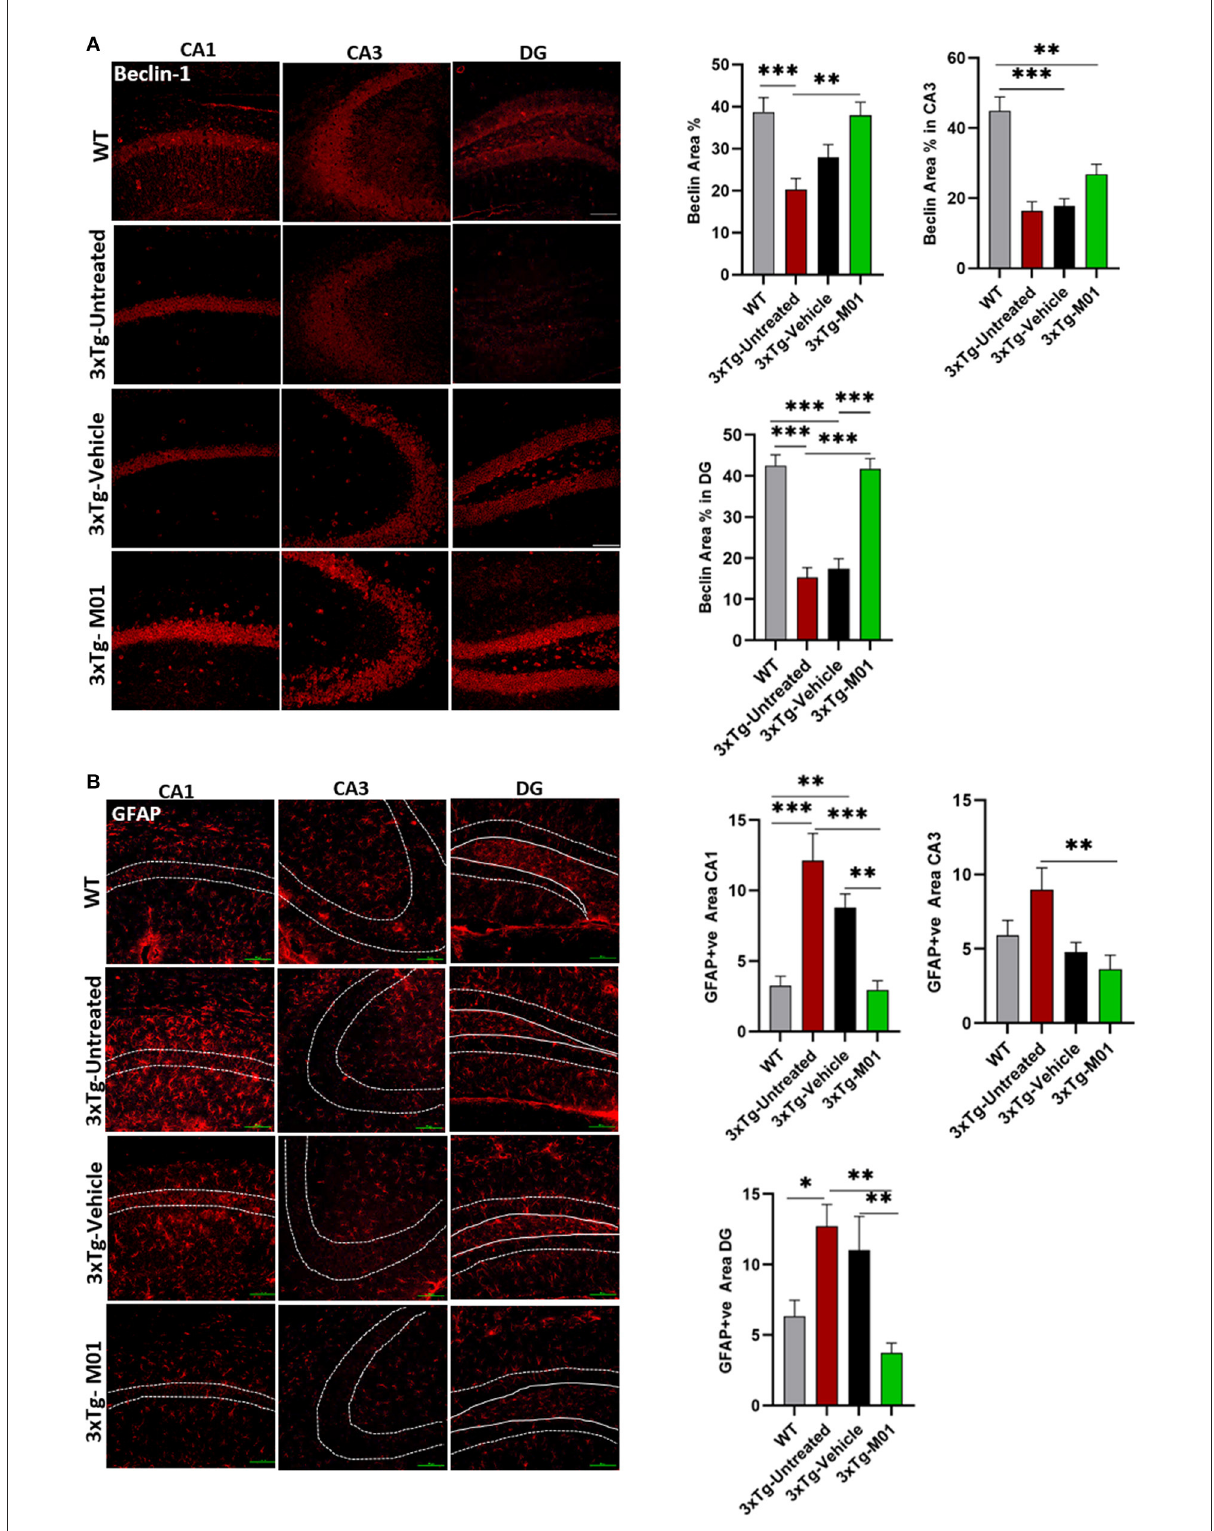
FIGURE4 M01 administration increased beclin-1 and decreased GFAP expression levels in the hippocampus of 3xTg-AD mice. (A) The expression of Beclin-1 in CA1, DG, and CA3 significantly decreased in the 3xTg-untreated and -vehicle groups. M01 treatment increased the expression in